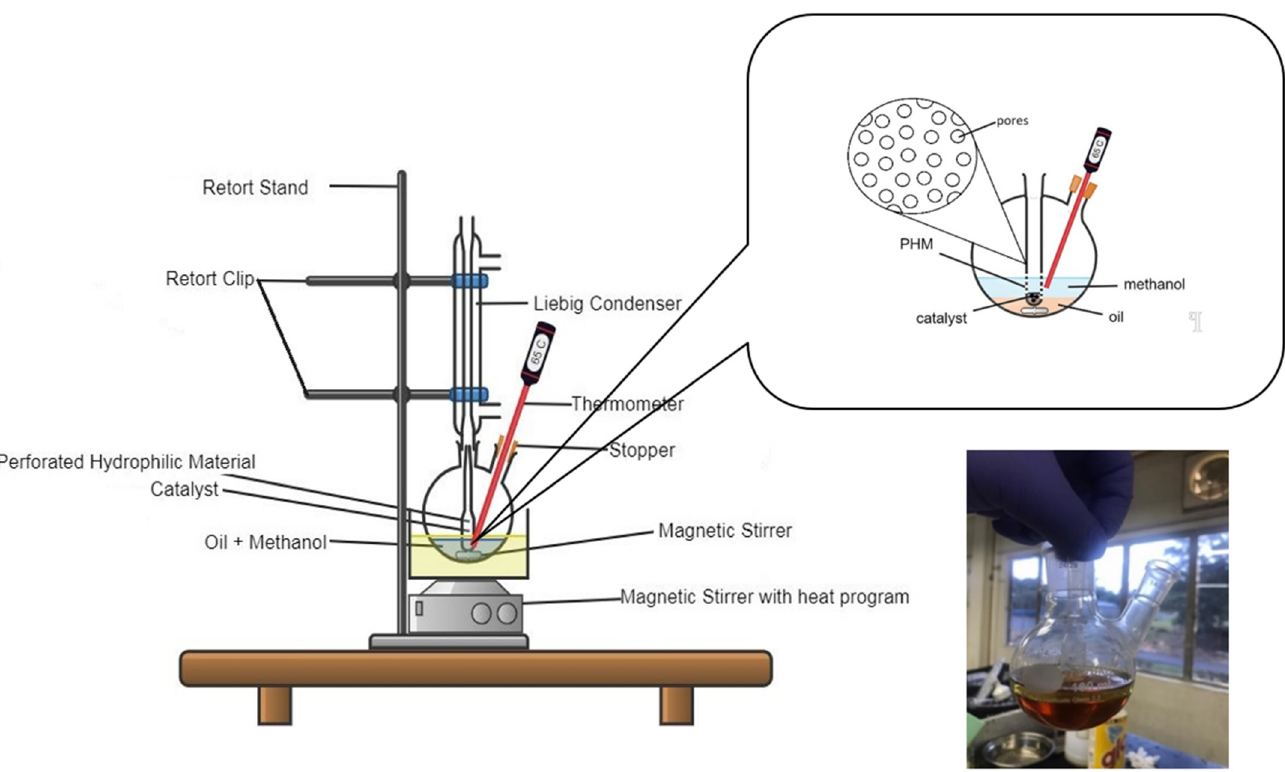
Figure 10. Schematic design of the open-system reactor for the transesterification process with the application of the fabricated PHM porous catalyst container.